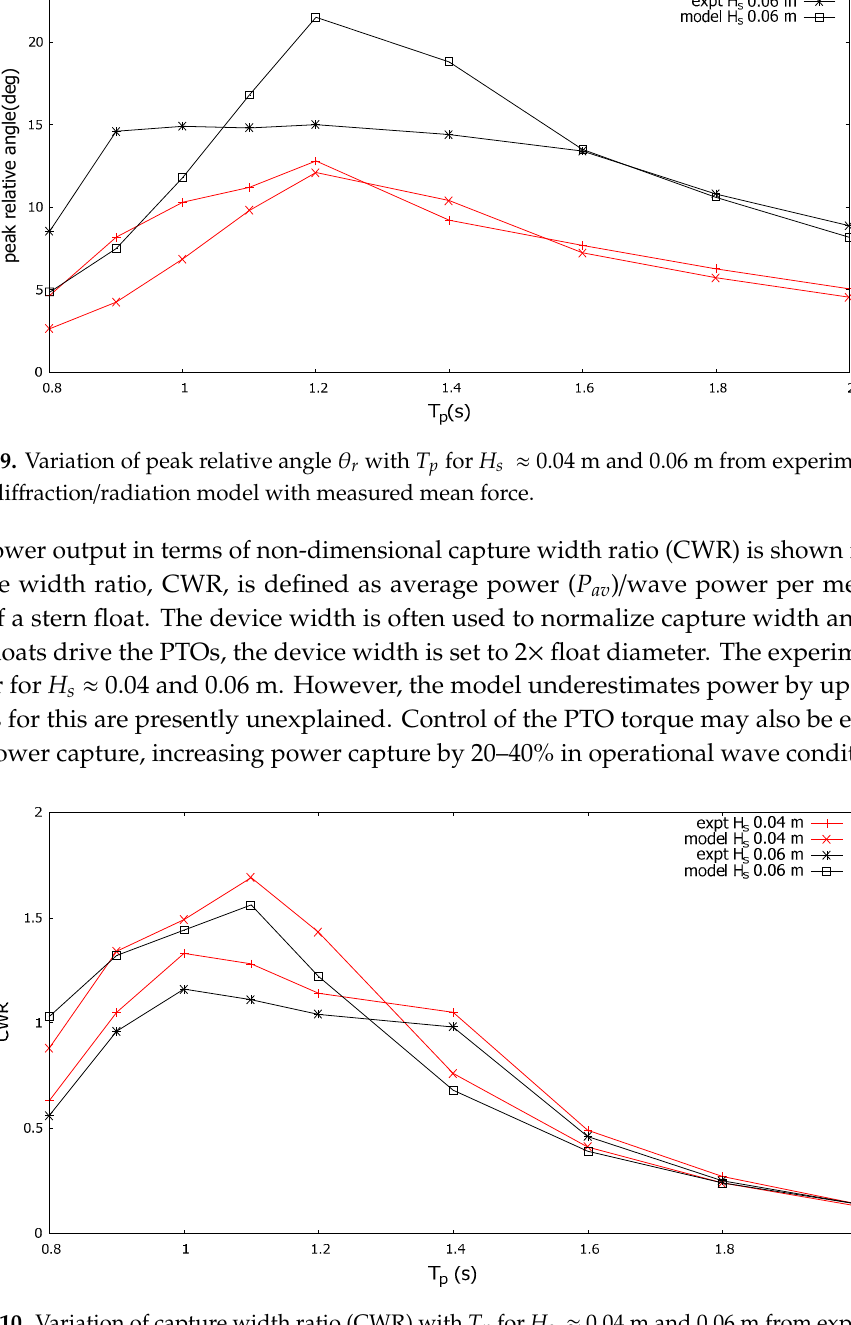
Figure 8. Variation of rms relative angle 𝜃 (cid:3045) with 𝑇 (cid:3043) for 𝐻 (cid:3046) ≈ 0.04 m and 0.06 m from experiment and linear diffraction/radiation model with measured mean force.